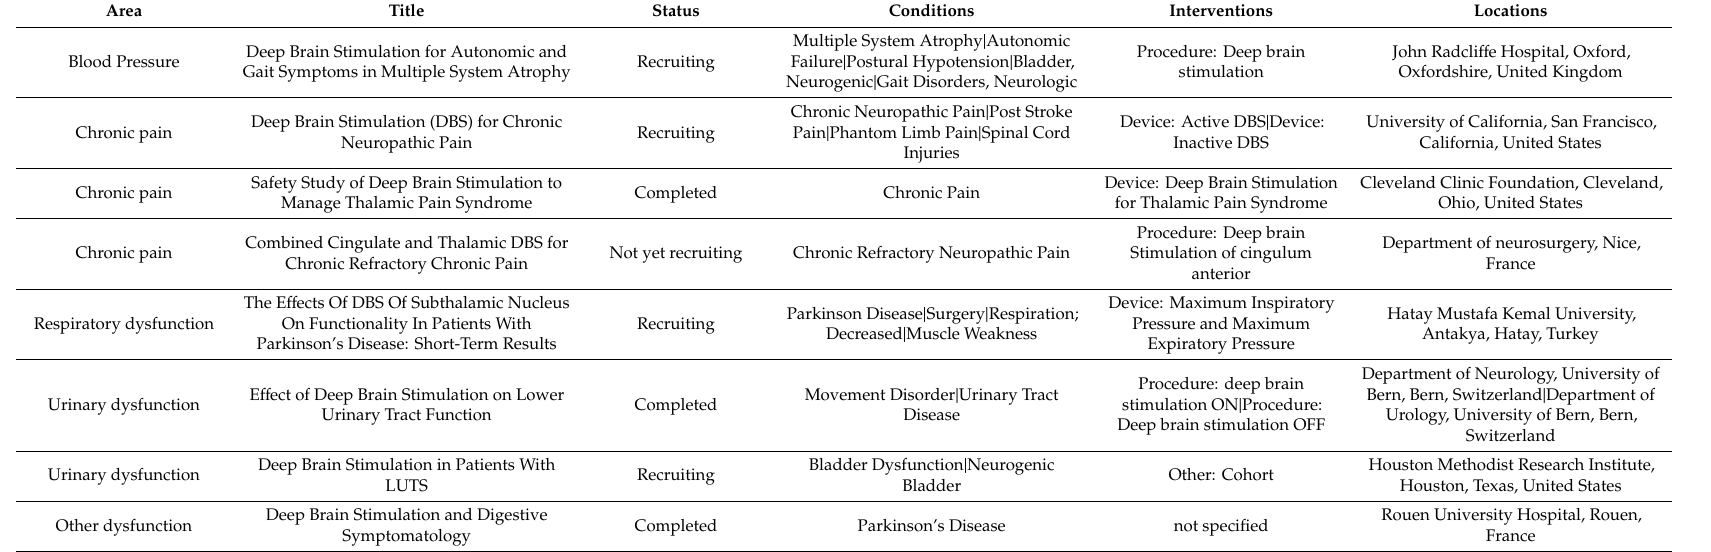
Table 2. Unpublished Registered Clinical Trials relating to DBS and Palliative symptoms.